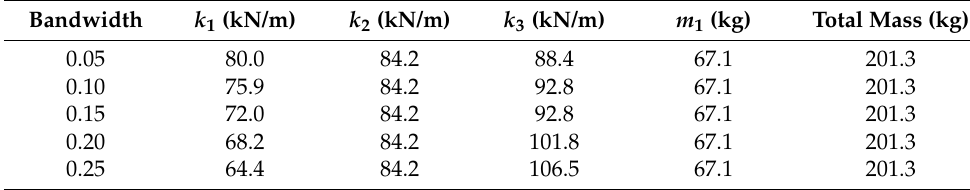
Table 7. Design parameters of MTMD under different bandwidths.